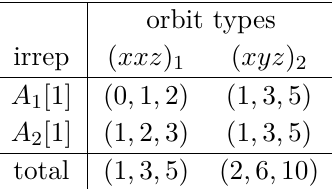
Table 15. As for table 10 but for P = ( n 1 , n 1 , n 2 ) . See table 9 for explicit orbit-type